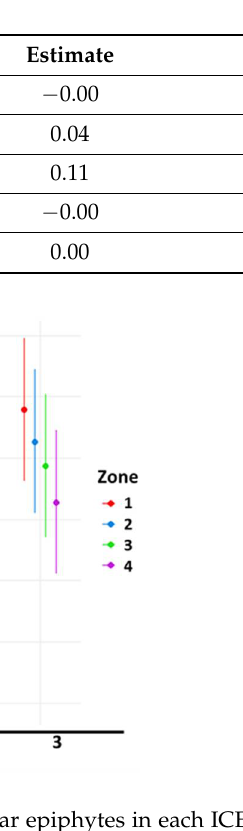
Figure 2. Amount of water in non-vascular epiphytes in each ICE-av CLASS (0 to 3) and in each ecological zone of the phorophyte (1, 2, 3 and 4). Bars indicate 95% confidence interval.